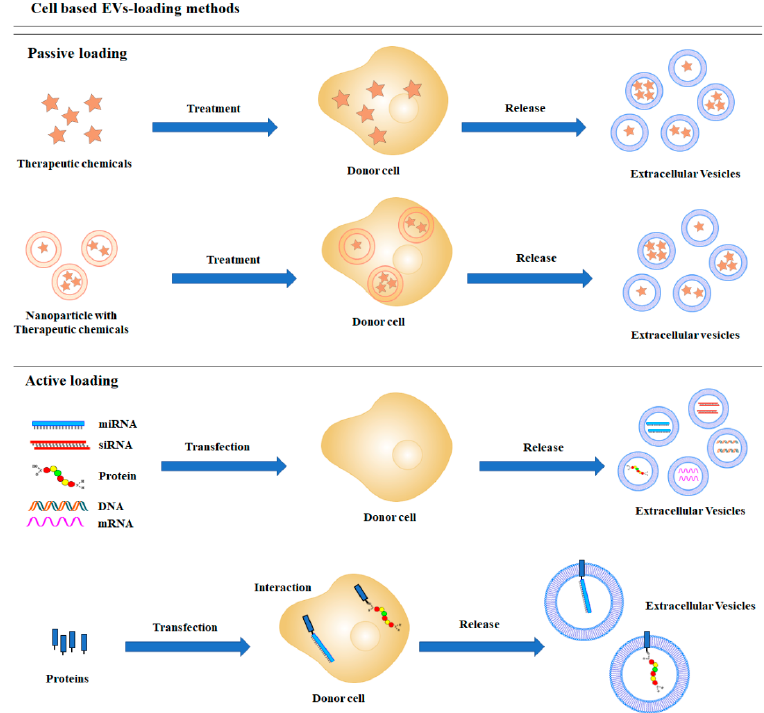
Figure 1. Schematic diagrams of cell-based cargo loading methods.